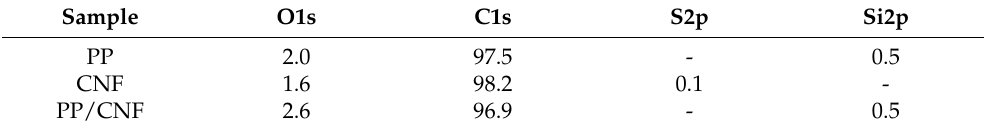
Table 2. Chemical composition and surface atomic % of PP, CNF and PP/5 wt.% CNF